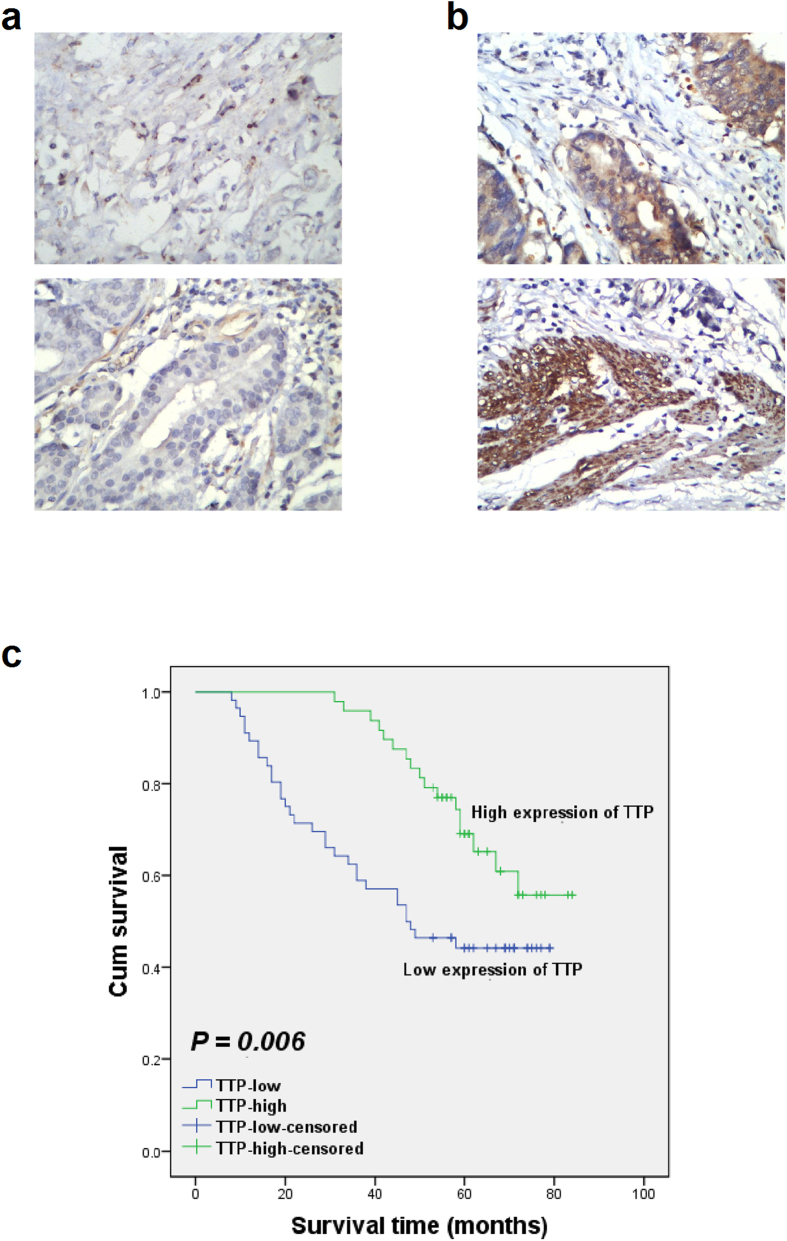
Expression of TTP is correlated with clinicopathological features and overall survival of gastric cancer patients (Group A).(a) Representative images of TTP immunohistochemical staining (IHS: top, 1; bottom, 1) for TTP-low subgroup (IHS ≤ 3, n = 56). (b) Representative images of TTP immunohistochemical staining (IHS: top, 4; bottom, 6) for TTP-high subgroup (IHS > 3, n = 48). (400× magnification) (c) Kaplan-Meier survival curve for gastric cancer patients with different TTP expression levels.